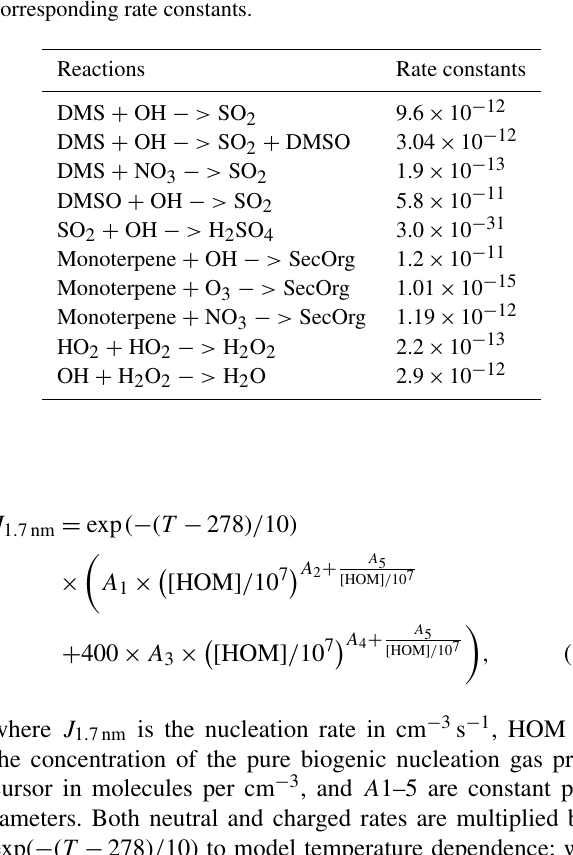
Table 1. The chemical reactions in the offline chemistry and the corresponding rate